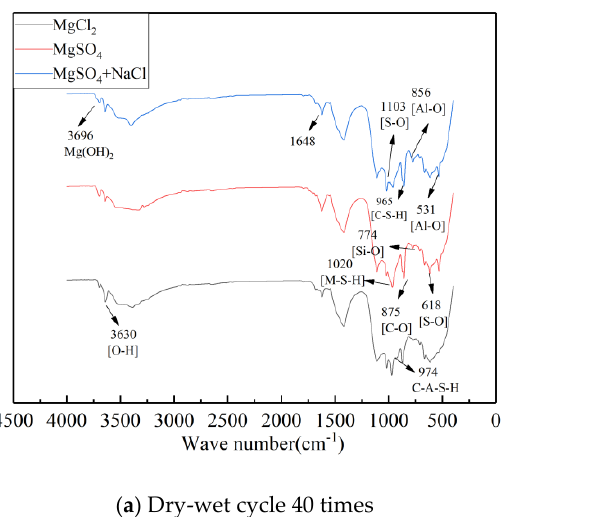
( b ) 120 cycles Figure 17. Microscopic morphology of MK concrete in clear water solution.